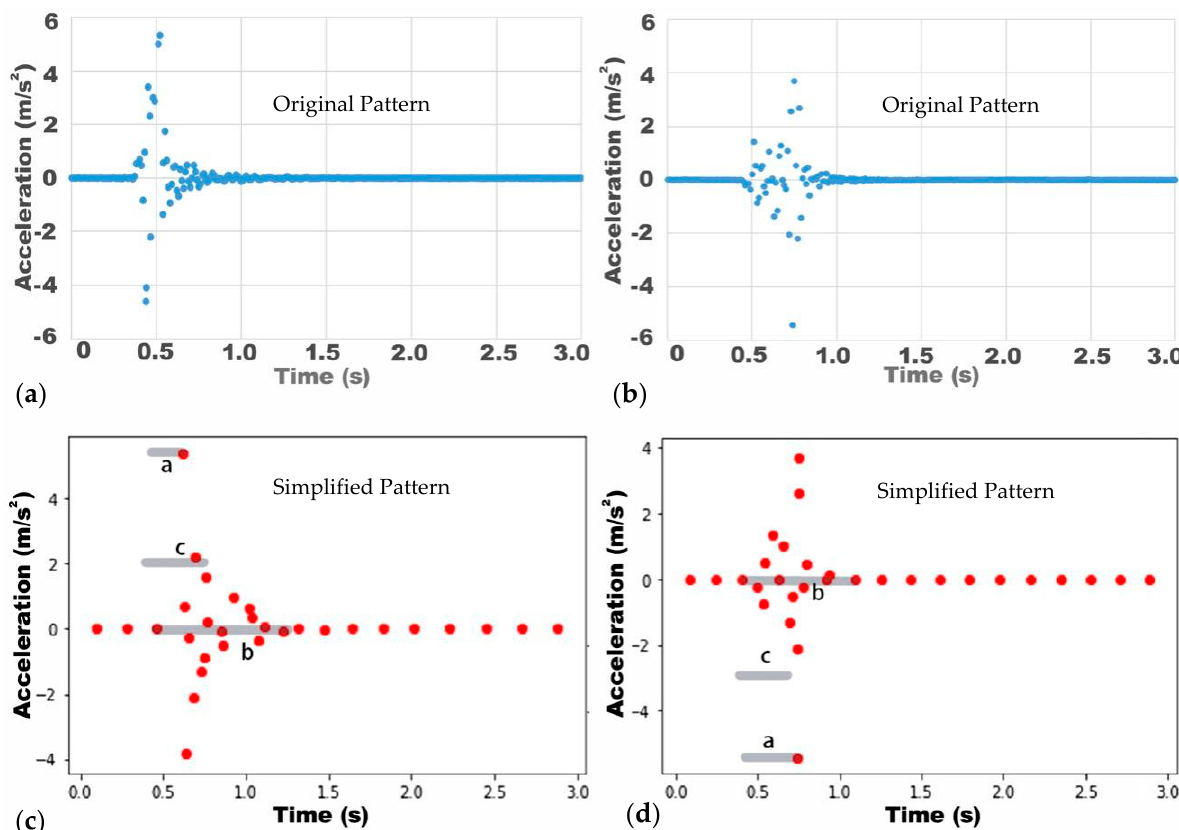
Figure 14. Features extracted from pattern for forward and backward falls. ( a ) Original Pattern of backwards fall; ( b ) Original Pattern of forward fall; ( c ) Simplified Pattern of backwards fall; ( d ) Simplified Pattern of forward fall.